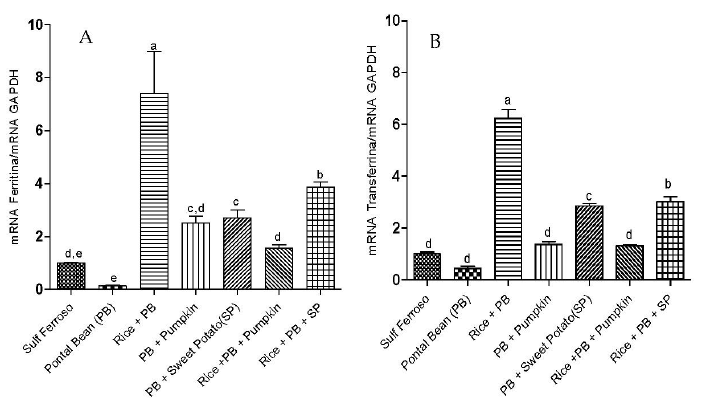
Figure 1. Effect of the ingestion of different combinations of staple food crops from micronutrients biofortification program and ferrous sulfate on the gene expression of proteins in liver tissue. RT-PCR Analysis. ( A ) Ferritin; ( B ) Transferrin. FS: Sulfate Ferrous; PB: Pontal Bean; PB + R: Pontal Bean + Rice; PB + A: Pontal Bean + Pumpkin; PB + SP: Pontal Bean + Sweet Potato; PB + R + P: Pontal Bean + Rice + Pumpkin; PB + R + SP: Pontal Bean + Rice + Sweet Potato. Different letters indicate statistical differences at 5% probability by Duncan test.